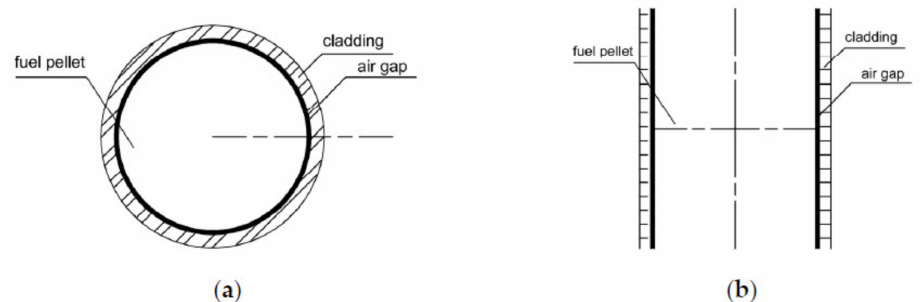
Figure 12. The fuel rod cross-section: ( a ) radial; ( b ) axial.